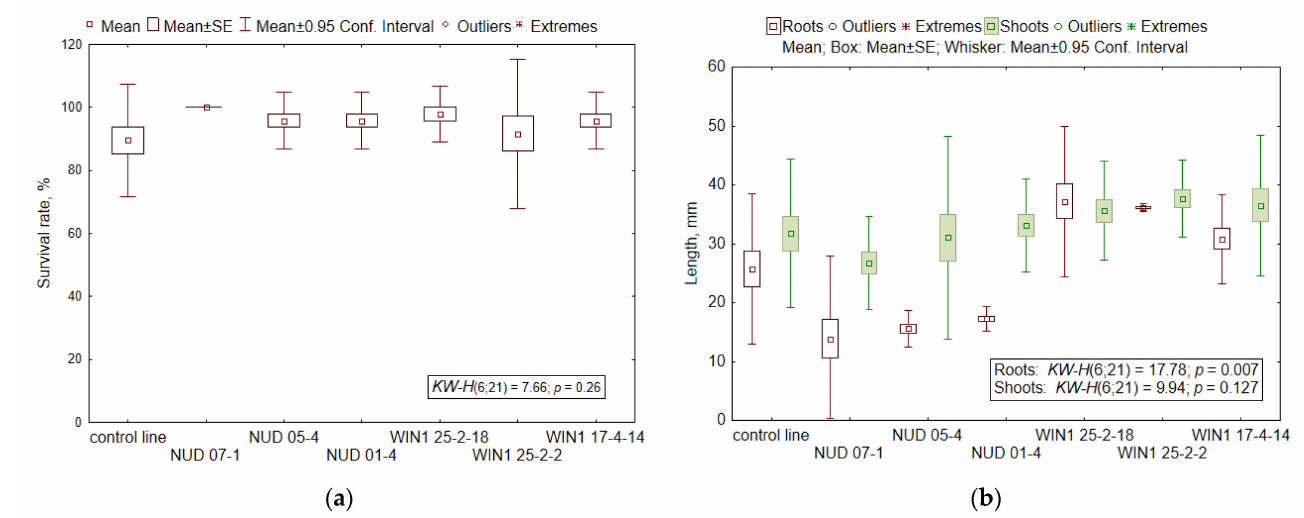
Figure 2. Viability indicators in seedlings of barley KO lines. ( a ) The survival rate, % (number of samples for each line, N = 3); ( b ) shoot ( N = 43–48) and root lengths ( N = 44–48), mm. The mean values, standard error (SE) and 95% confidence interval are indicated in the Figure 2. The nonparametric Kruskal-Wallis (KW) method was used, where H is the criterion value, p -value is the significance level. The degree of freedom ( df ) values of the numerator and denominator of H -criterion are given in